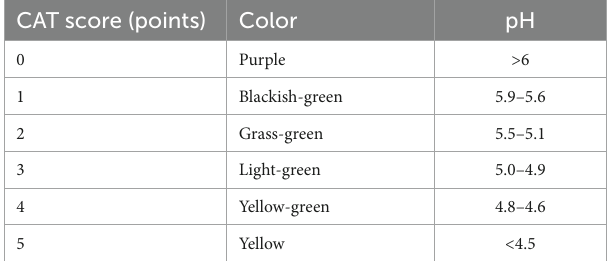
TABLE 3 Caries activity test (CAT)